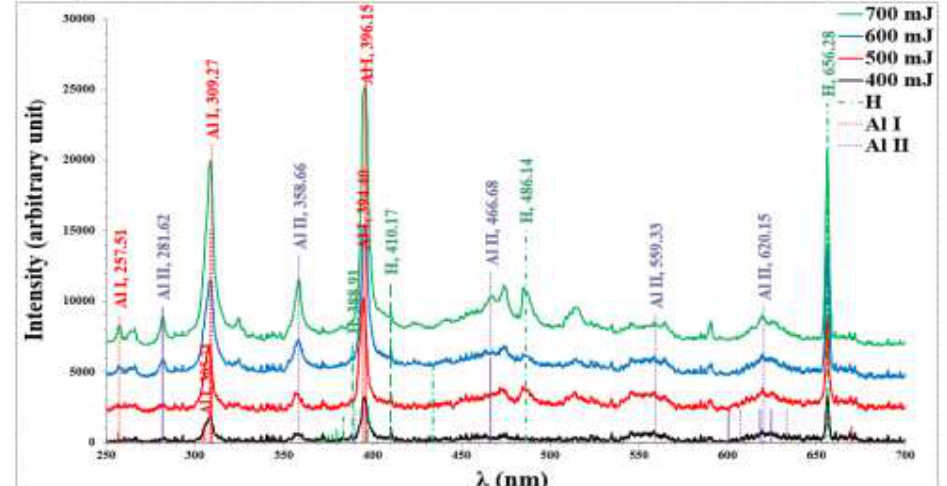
Figure 6: Emission spectra of the laser-induced Al bulk target with laser energies of 400, 500, 600, and 700